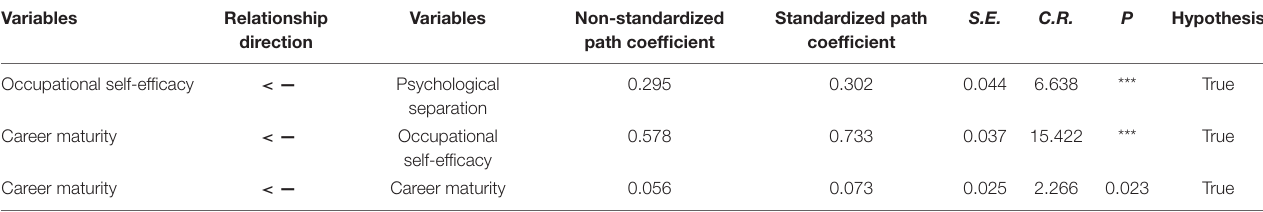
TABLE 4 | Path coefficient.